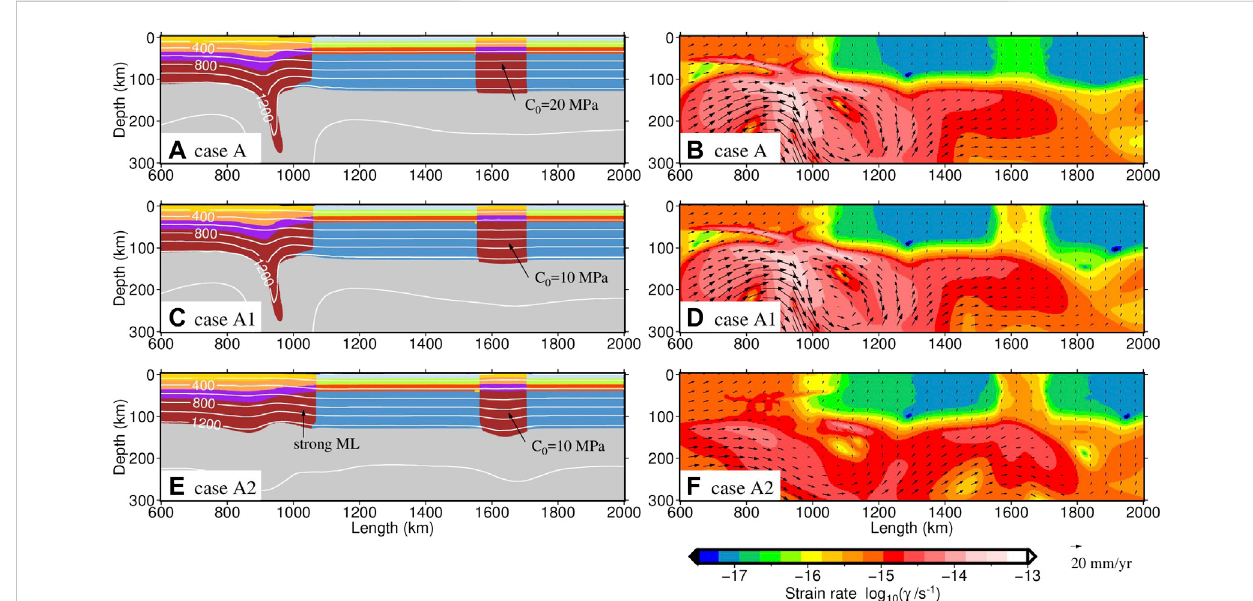
FIGURE 4 Comparisons of lithospheric deformation (A, C and E) and strain rate localization (B, D and F) for different cases (cases A, A1, and A2) after 10 Myr. Different colors in (A,C and E) indicates different materials, which are consistent with that in Figure 2A. White lines in (A,C and E) indicate the isotherm. Black arrows in (B,D and F) show velocity vectors.